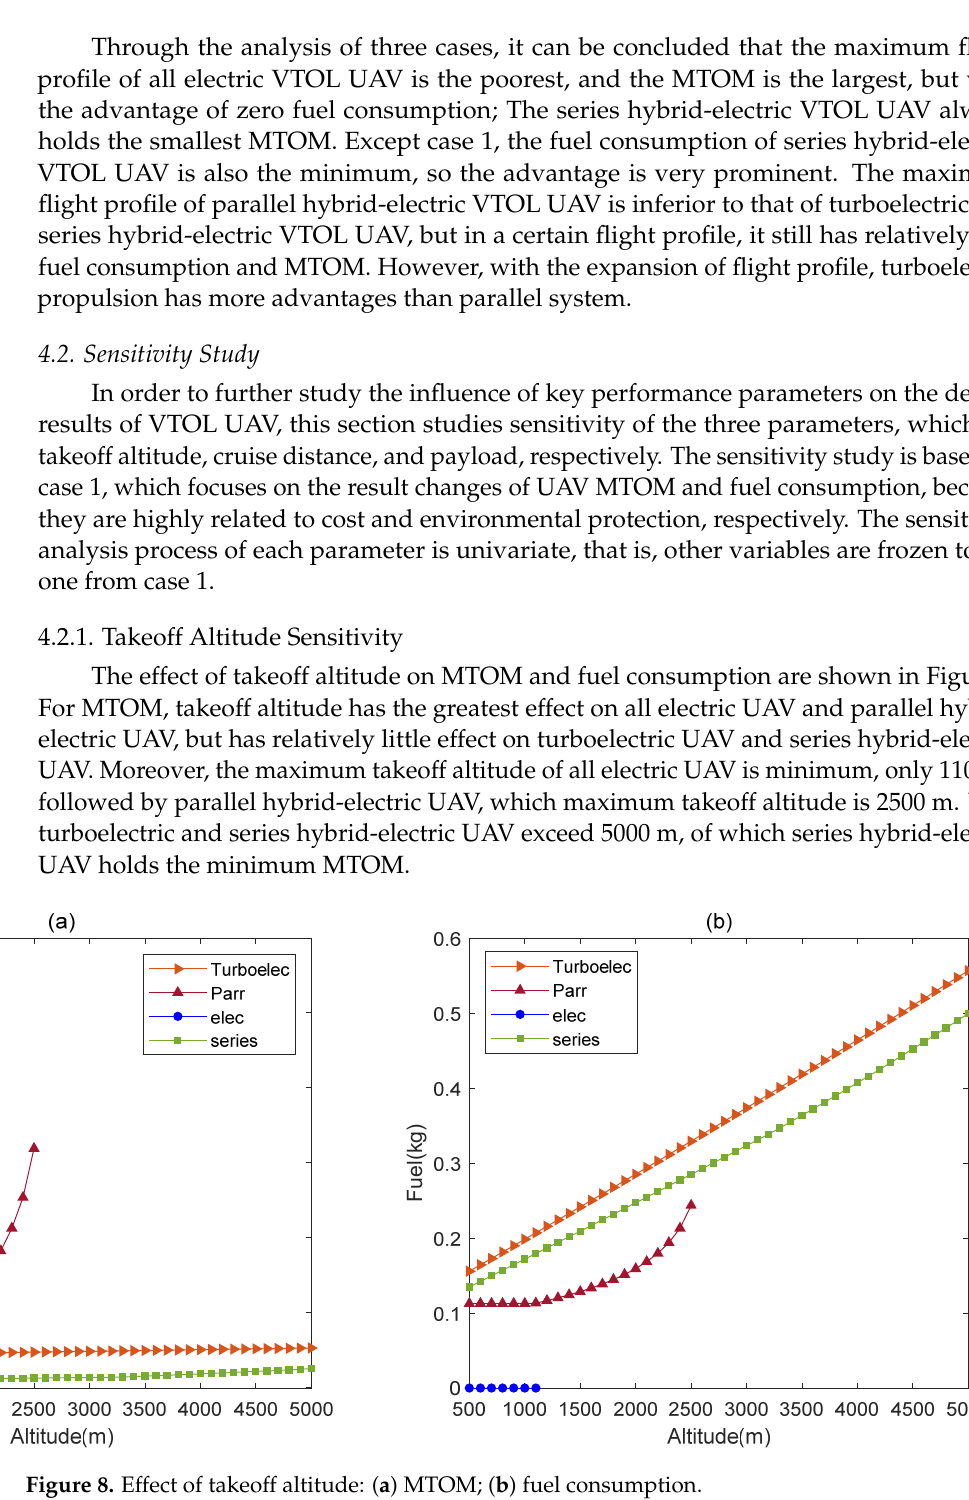
Figure 8. Effect of takeoff altitude: ( a ) MTOM; ( b ) fuel consumption. In terms of fuel consumption, all electric propulsion has zero emission, and parallel hybrid-electric propulsion takes the second place. However, the takeoff altitude of these two of propulsion UAV is limited. The fuel consumption of the series hybrid-electric UAV is less than that of the turboelectric UAV, and the turboelectric UAV has the largest fuel